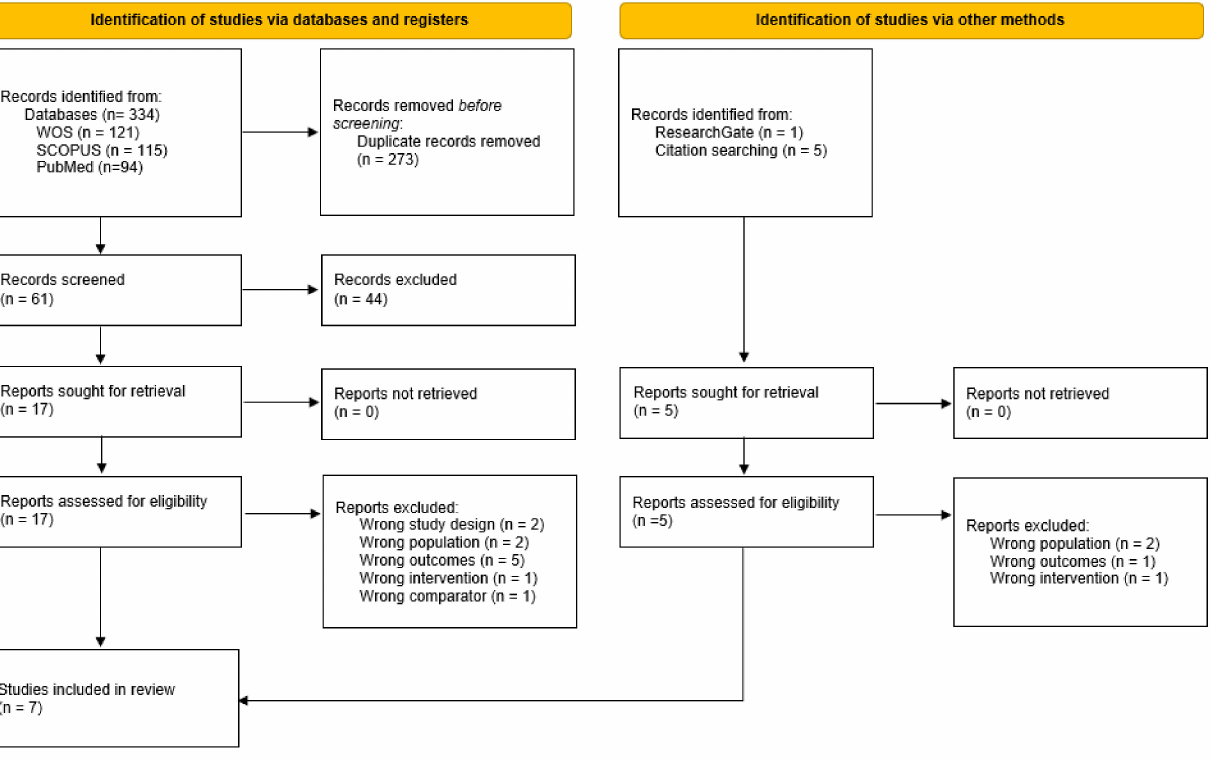
Figure 1. Flow diagram depicting the identification and selection processes of relevant studies accord- ing to Preferred Reporting Items for Systematic Reviews and Meta-Analyses (PRISMA) guidelines.